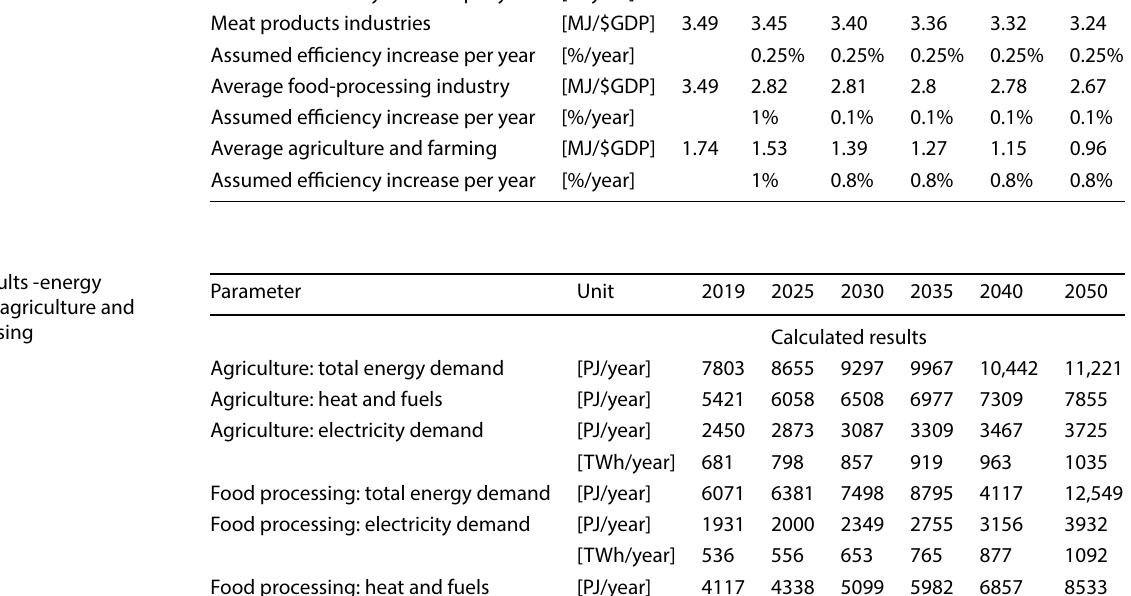
Table 5 Input—Energy intensities for selected food- processing industries